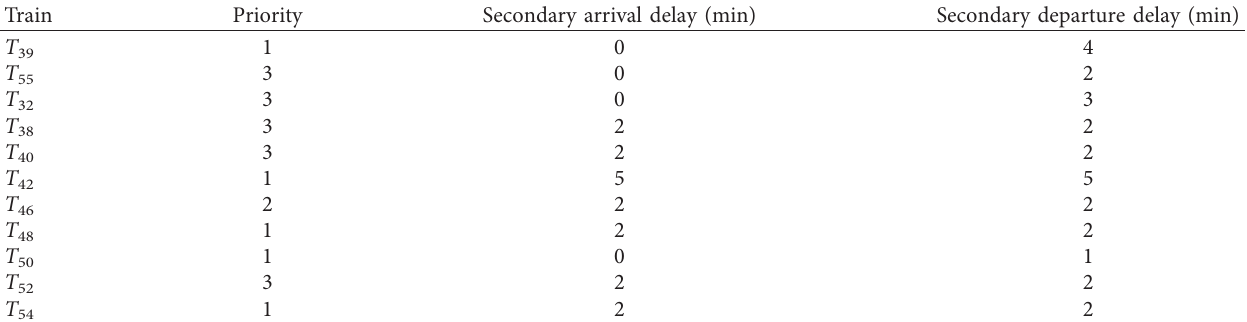
Table 10: Amount of secondary delay for the trains obtained by CPLEX-WV for the scenario (70, 10, 0). Train